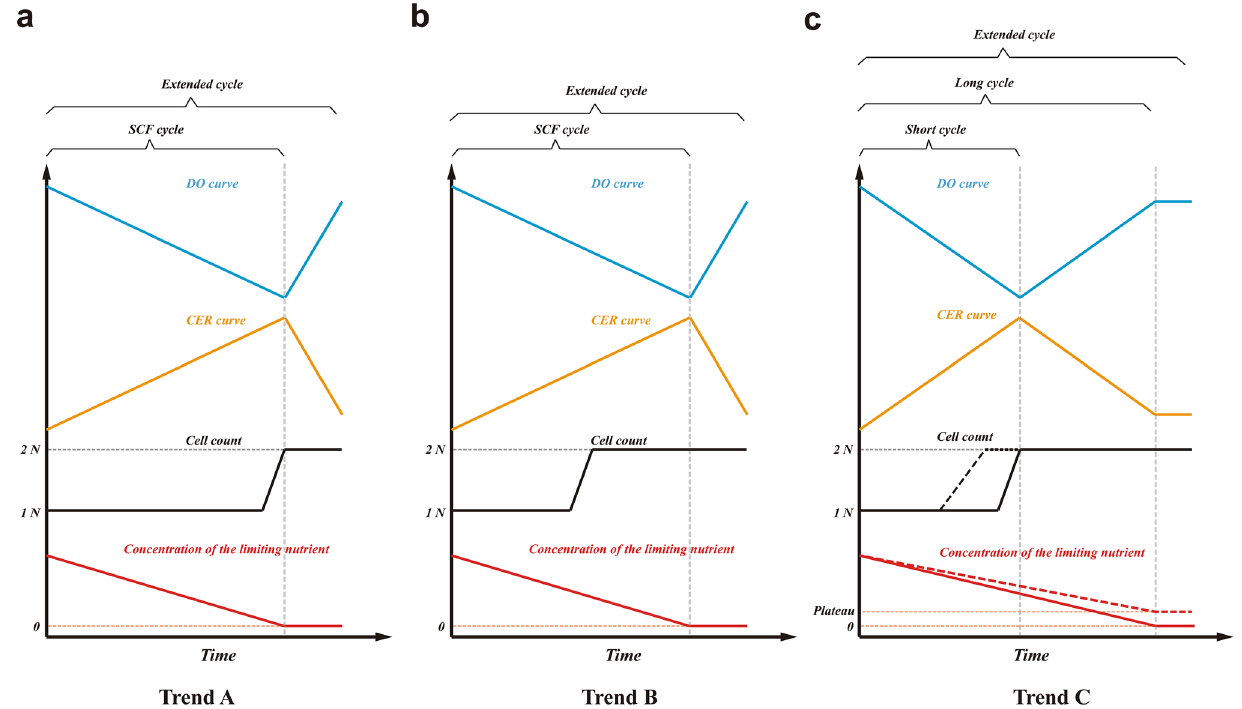
Figure 4. Schematic of the conceptual trends in characteristic events during SCF. DO curve (for aerobic conditions) is shown in blue, CER curve (for aerobic or anaerobic conditions) in orange, cell count in black, and concentration of the limiting nutrient in red. Straight lines are used to describe general trends. ( a ) Trend A: Optimum in control parameter (DO minimum or CER maximum), the end of synchronized division, and the depletion of the limiting nutrient co-occur at the end of the SCF cycle. An extended cycle allows for a delay in cycling. ( b ) Trend B: Optimum in control parameter (DO minimum or CER maximum) and the depletion of the limiting nutrient co-occur at the end of the SCF cycle, but synchronized cell division ends in the middle of the cycle. An extended cycle allows for a delay in cycling. ( c ) Trend C: DO or CER plateaus as limiting nutrient becomes depleted (or reaches its own plateau, the red dashed line) at the end of the SCF long cycle, but synchronized cell division ends in the middle of the long cycle (corresponding to an optimum in DO or CER). In trend C, an SCF short cycle can be implemented when cycling is done at the time of the optimum in control parameters but partially synchronized cell replication (the black dashed line) starts and ends in the middle of the short cycle. The limiting nutrient is not depleted by the end of the short cycle. An extended cycle allows for a delay in cycling beyond the end of a long chronized cell division, and (3) the depletion or plateau of the limiting nutrient. The three trends based on these events are summarized in Fig. 4. Nitrogen or carbon sources are frequently set as the limiting nutrients dictating the cycling of SCF operation. Control parameters used to establish cycling conditions have included DO, CER, and ORP 7 . Mass flow rate of the exit gas has also been used for SCF of S. cerevisiae Superstart™ producing ethanol 8 and was a direct reflection of CER under anaerobic conditions. In studies of Pseudomonas putida ATCC 12633 degrading phenol 12 and Acinetobacter calcoaceticus RAG-1 ATCC 31012 grown on hexadecane 32 , CER patterns were found to mirror DO patterns, and the CER maximum aligned with the DO minimum. Under aerobic conditions, the relation- ship between CER and DO generally holds, with exceptions. However, ORP patterns during SCF operation are generally more complex than other parameters. For example, ORP increased for P. putida ATCC 12633 degrad- ing toluene 16 , but decreased when Pseudomonas denitrificans ATCC 13867 was used for the removal of oxidized nitrogen 15 . The presence and absence of oxygen in these two studies were likely responsible for these diverging patterns. Overall, during SCF operation, the minimum in DO coincides with the maximum in CER (under aerobic conditions), and the ORP inflection point occurs near this point 15,16 . Many early SCF studies exhibited Trend A (Fig. 4a), in which the depletion of the limiting nutrient coincided with the characteristic point in the control parameter (OD, CER or ORP) and with the completion of synchro- nized cell division. SCF cycling was triggered upon this concurrence unless an extended cycle strategy was applied. The first implementation of SCF, for B. subtilis ATCC 21332, showed the minimum in DO corresponded with the depletion of the nitrogen source and the end of OD doubling 18 . The end of synchronized cell doubling (a step-wise increase in cell count) co-occurred with nitrogen source exhaustion and with a minimum in DO when SCF was used to produce sophorolipids by Candida bombicola ATCC 22214 24 and citric acid by Candida lipolytica ATCC 20390 10 . The same pattern was observed for A. calcoaceticus RAG-1 ATCC 31012 grown on ethanol 6 and for P. putida ATCC 12633 degrading aromatic compounds 13 . Similarly, when P. denitrificans ATCC